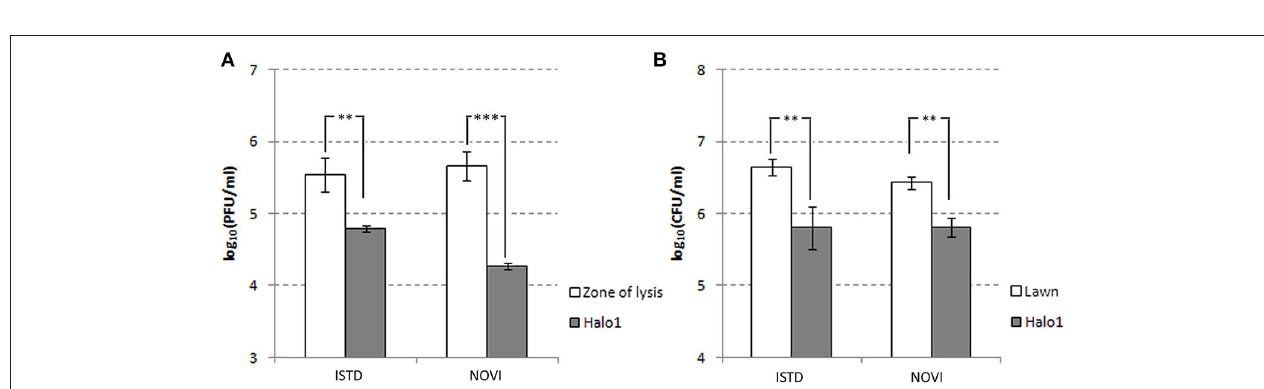
FIGURE 5 | Graphic depiction of halo enlargement (A) and the Petri dish that was analyzed (B) . Samples were taken in duplicate each day for 3 consecutive days, and PFUs and CFUs were counted and pondered according to the weight of the agar pieces. As controls, the unaffected lawn area and zone of lysis were analyzed in the same way.